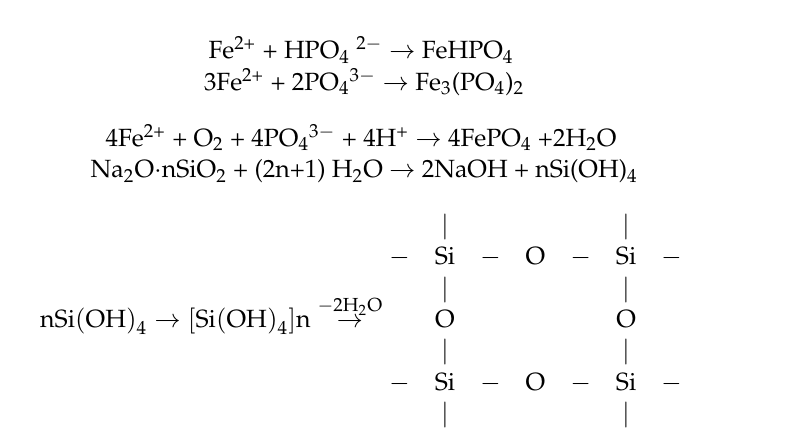
Figure 3. Evolution of the core-shell structure of magnetic powder. ( 1 ) Phosphate coating process; ( 2 ) SiO 2 coating process.